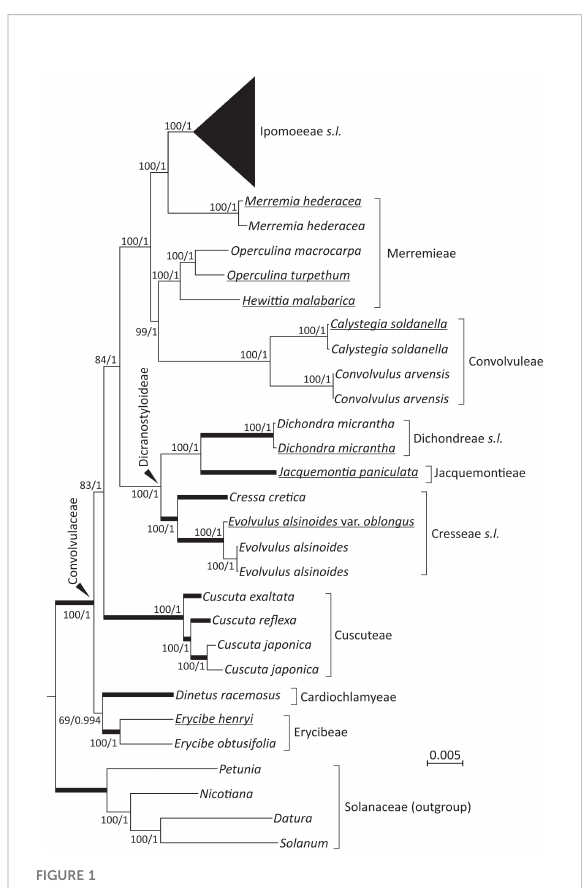
FIGURE 1 Plastid phylogenomics of representative Convolvulaceous genera and tribes. The topology is based on a ML tree inferred from a concatenation of 78 plastid protein-coding genes. Values along branches re fl ect bootstrap support (%) for ML trees and posterior possibilities for Bayesian inference (BI) trees. Thick branches are shortened to 1/10 of their real lengths. Underlined taxa were sequenced in this